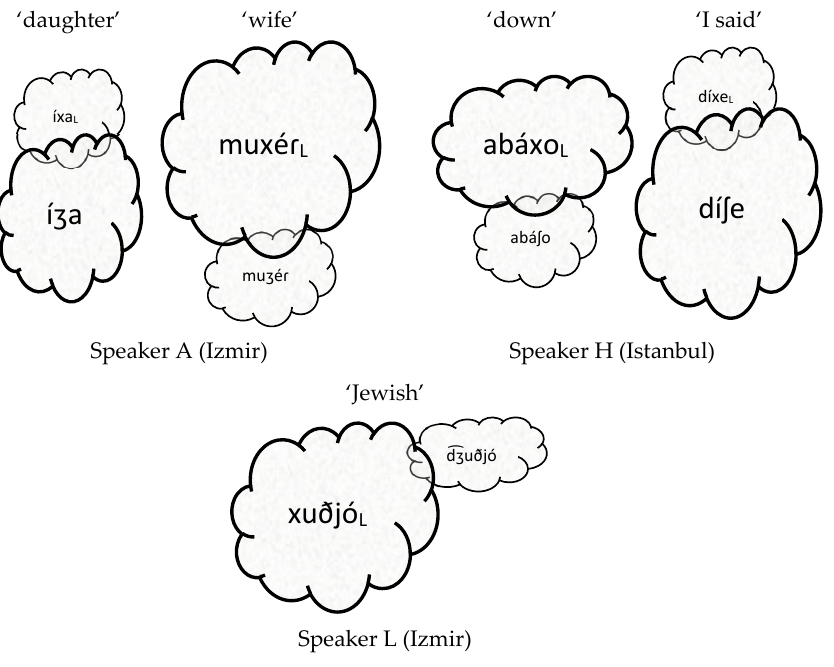
Figure 4. Hypothesized exemplar representations in Turkish JS, based on token frequency counts of three speakers from the COJUT XXI.